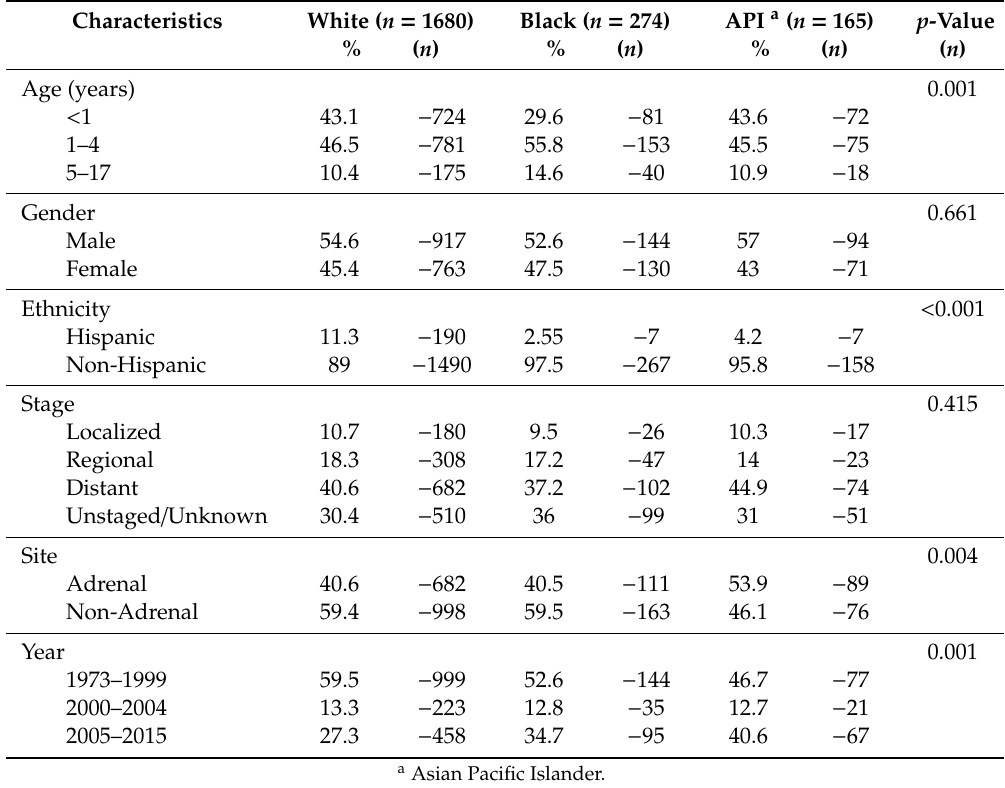
Table 1. Demographic and clinical characteristics, by race, of pediatric patients in the SEER registry diagnosed with neuroblastoma, 1973–2015.